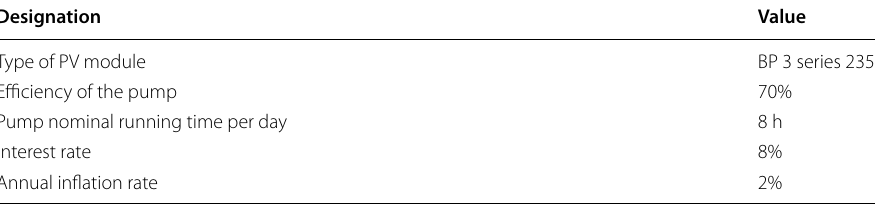
Table 5 Parameters used for